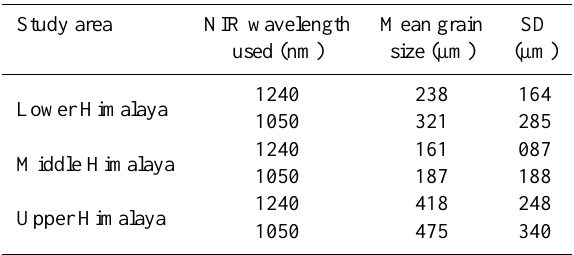
Table 4. Grain size retrieved at station-1 of lower Himalaya and station-2 of middle Himalaya; vertical homogeneity is the ratio of retrieved grain size at the 1050nm to the 1240nm wavelength chan-